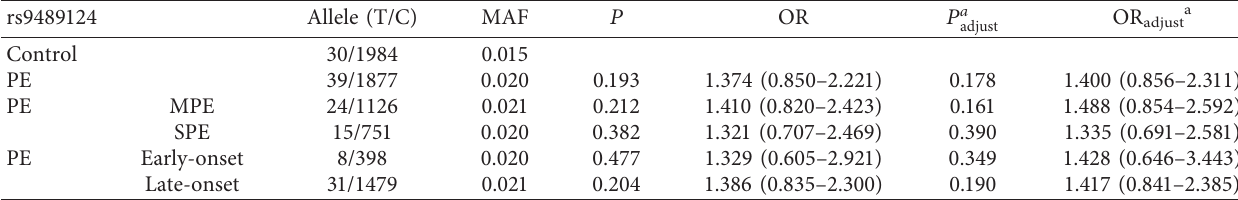
Table 5: Allele frequencies of ROS1 rs9489124 in women with and without PE.